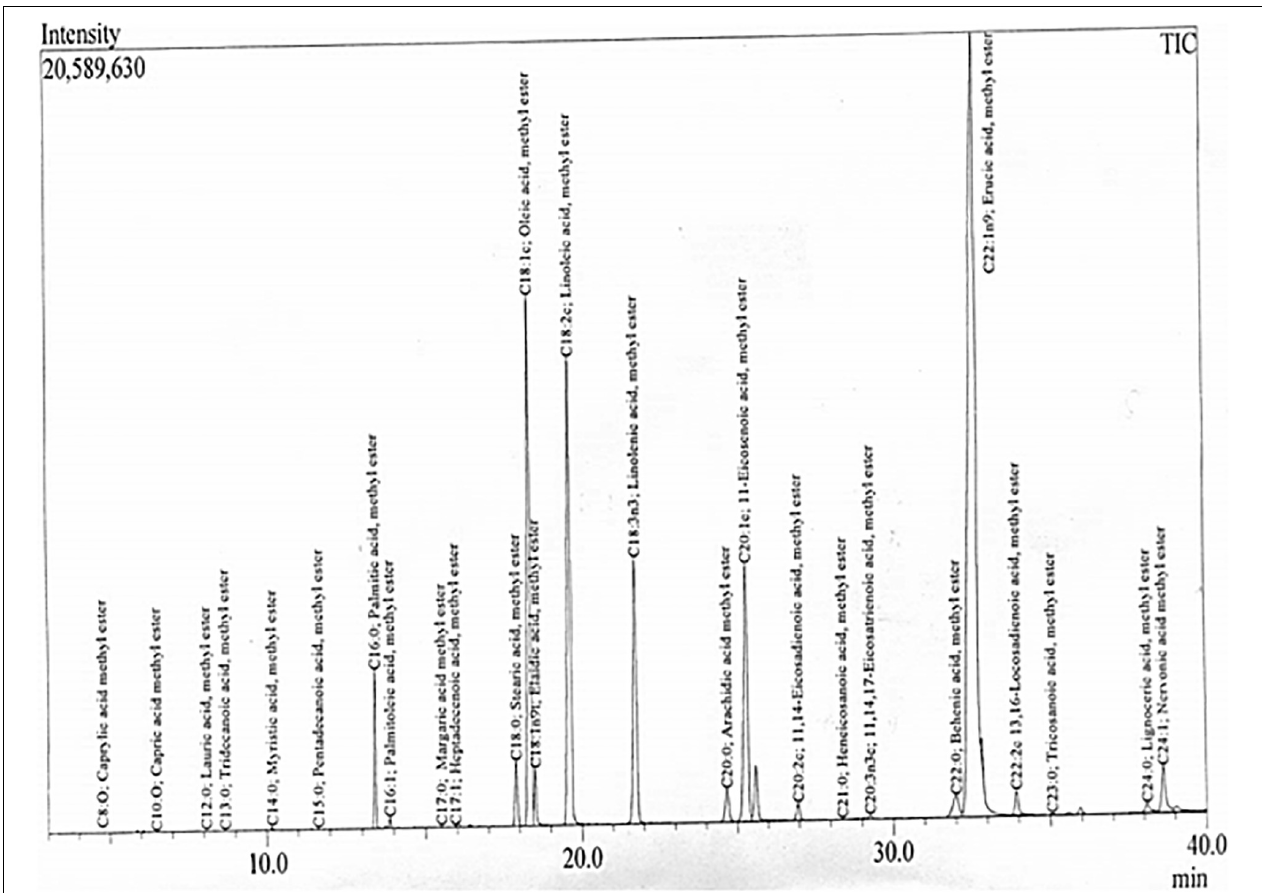
FIGURE 12 | GC/MS Chromatogram Showing 28 Major Methyl Esters in Energy Crop Cocklebur Biofuel Sample.